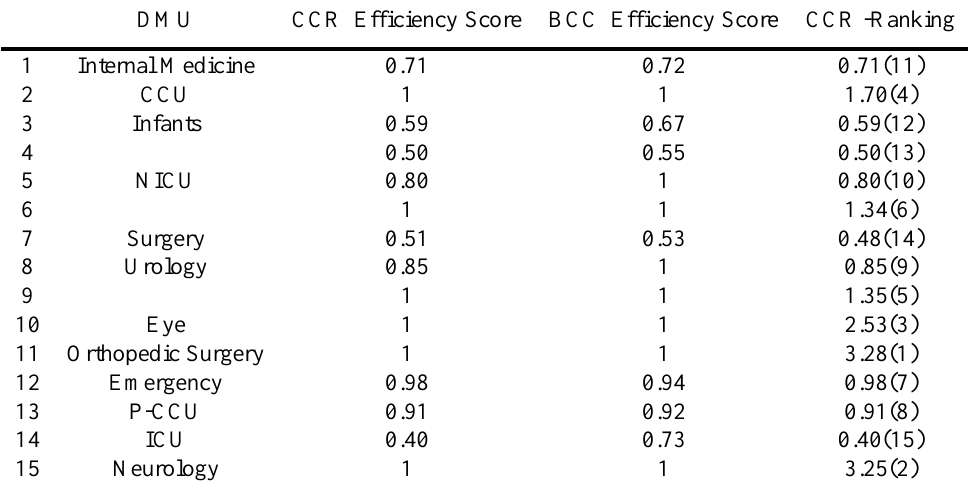
Table 6. Efficiency score and ranking in case study application in year 1395.